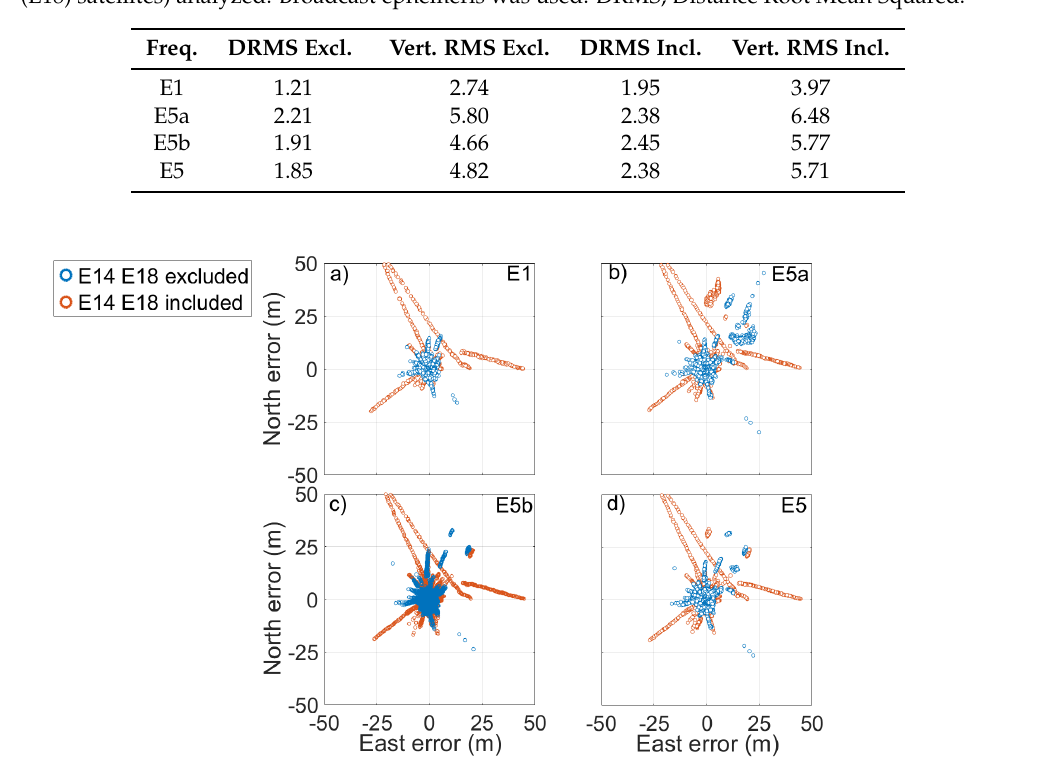
Figure 10. Scatter plot of the E1, E5a, E5b, and E5 single-point position error reported in ( a – d ). Blue and red markers represent errors when the solution was obtained by excluding or including the measurements coming from the Milena (E14) and Doresa (E18) satellites, respectively. The solution was achieved by using broadcast